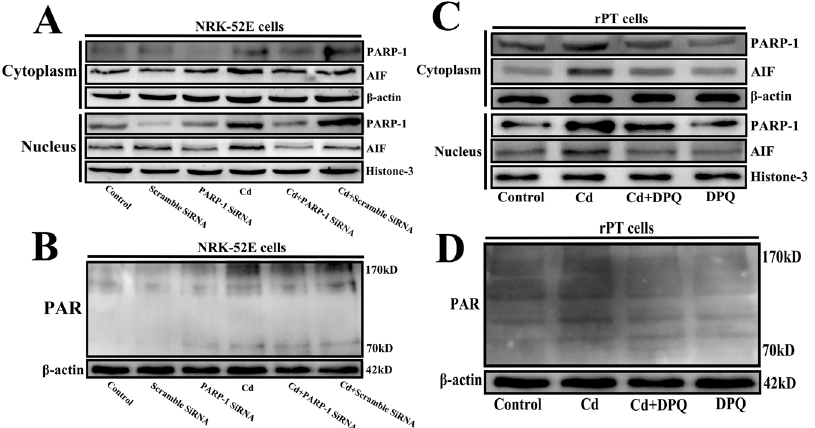
Figure 5. Inhibit the expression of PARP-1 protein attenuated renal tubular epithelial cells death that induced by Cd. ( A and B ) Western blotting analysis showed that transfection with PARP-1 SiRNA inhibited the expression of PARP-1, PAR polymer and mitigated the increase of nuclear AIF in NRK-52E cells. ( C and D ) Western blotting analysis showed that inhibit the expression of PARP-1 by DPQ reduced the level of PARP-1, PAR polymer and the nuclear AIF in rPT cells.